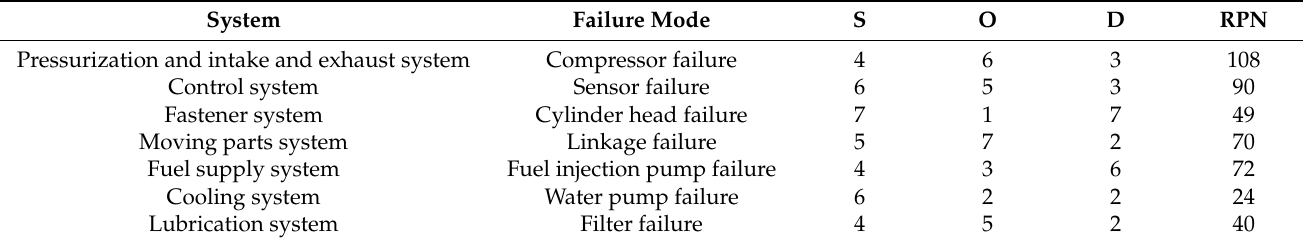
Table 7. The FMECA system-level results.